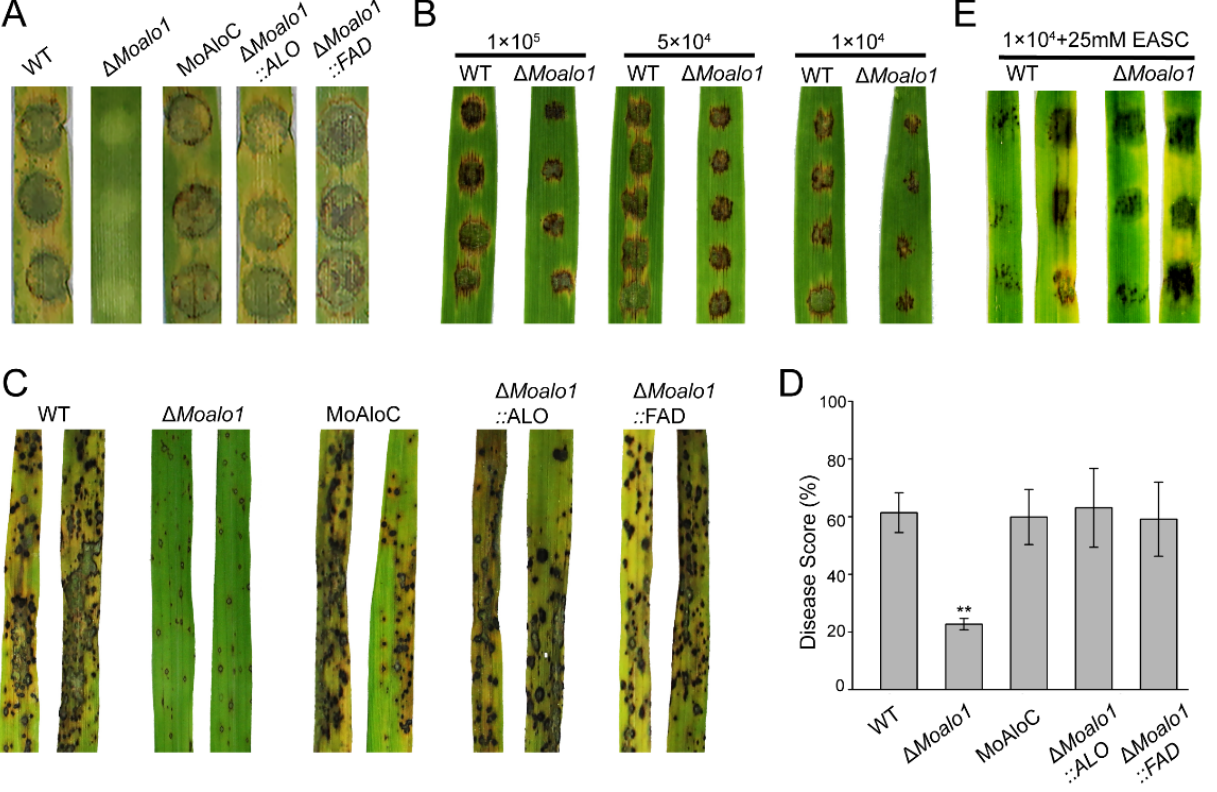
Figure 4. Pathogenicity assays. ( A ) Pathogenicity on barley leaves. Mycelial agar plugs were inoculated on 7-day-old barley leaves and photographed at 4 dpi. ( B ) Pathogenicity on rice leaves. Twenty microliters of conidial suspension with different concentrations (1 × 10 5 , 5 × 10 4 , and 1 × 10 4 conidia/mL) were inoculated on 2-week-old rice leaves and photographed at 5 dpi. ( C ) Pathogenicity on rice seedlings. Conidial suspensions (1 × 10 4 conidia/mL) of Guy11, ∆ Moalo1 , and the complementary strain MoAlo1C and mutant re-introduction of the FAD_binding_4 domain or the ALO domain were inoculated on 2-week-old rice seedlings and photographed at 7 dpi. ( D ) The disease score of the strains. After inoculation for 7 days, the rice seedlings were photographed and then the pathogenicity was calculated via PS software by calculating the area of the diseased spot. The disease score = the area of the diseased spot/the area of the total leaf. Prism 7.0 soft- ware was used to analyze the data. Asterisks indicate statistically significant differences ( t test, ** p < 0.01). ( E ) Pathogenicity test upon adding exogenous EASC. EASC (25 mM) was added to a 1 × 10 4 conidia/mL co- nidial suspension, and 20 μ L of the conidial suspension with EASC added was dropped onto de- tached rice leaves and photographed at 4 dpi.